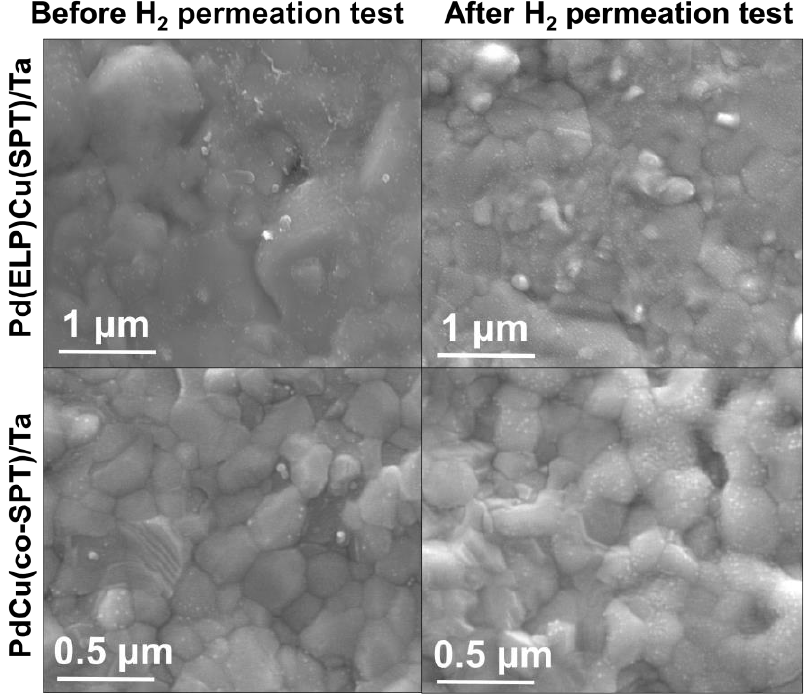
Figure 8. SEM (10 kV) images of surface of Pd(ELP)Cu(SPT)/Ta membranes before and after the H 2 permeation test for 10 h.